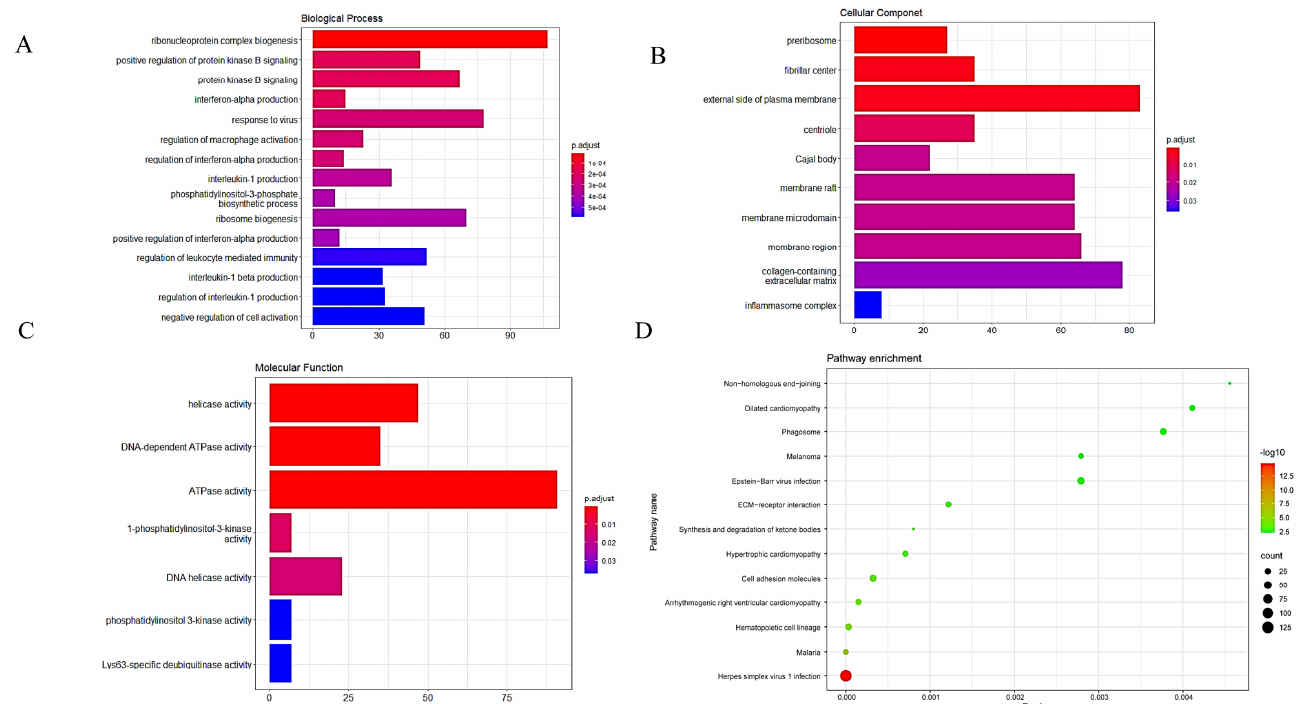
Figure 6. GO and KEGG analyses of the key module. ( A – C ) GO analysis of the key module. ( D ) KEGG analysis of the key module. BP, biological process; CC, cellular component; MF, molecular function.